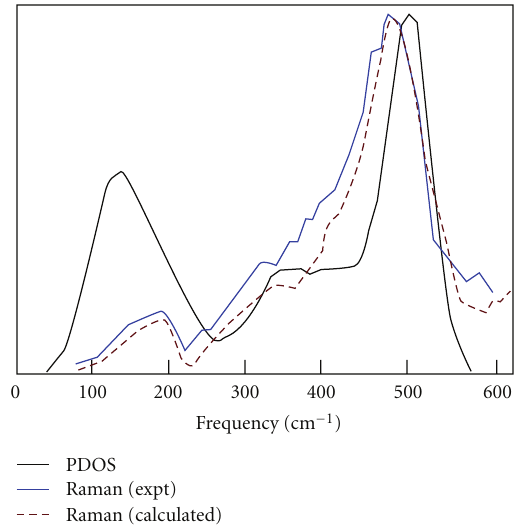
Figure 4: Comparison of experimental Raman profile (thin solid line) and calculated first-order Raman band of highly disordered Si (dashed line). The bold solid line is the calculated phonon density of states (PDOS) for highly disordered Si. The experiment and calculated Raman spectra are in good agreement. The di ff erence in the PDOS and the calculated Raman band shows the importance of matrix element e ff ects